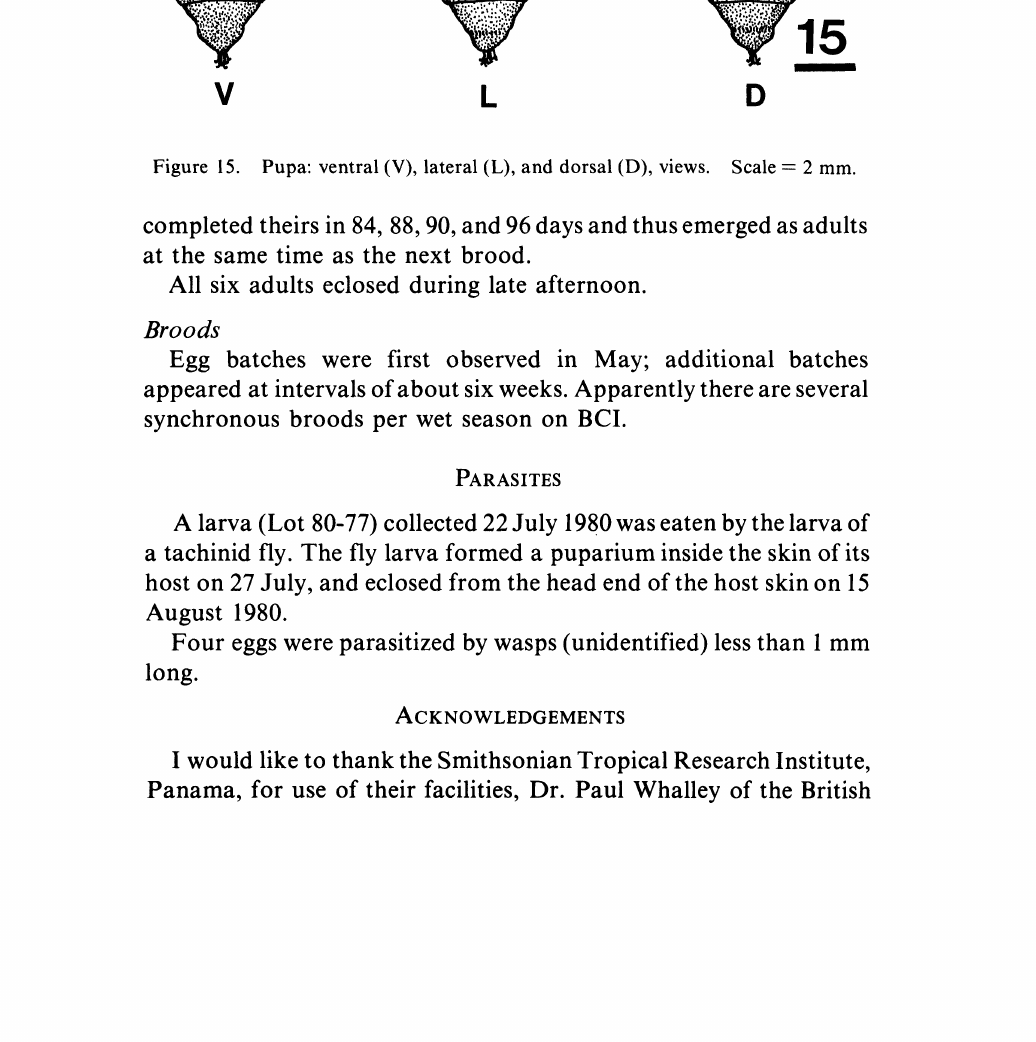
Figure 15. Pupa: ventral (V), lateral (L), and dorsal (D), views. Scale-- 2 mm. completed theirs in 84, 88, 90, and 96 days and thus emerged as adults at the same time as the next